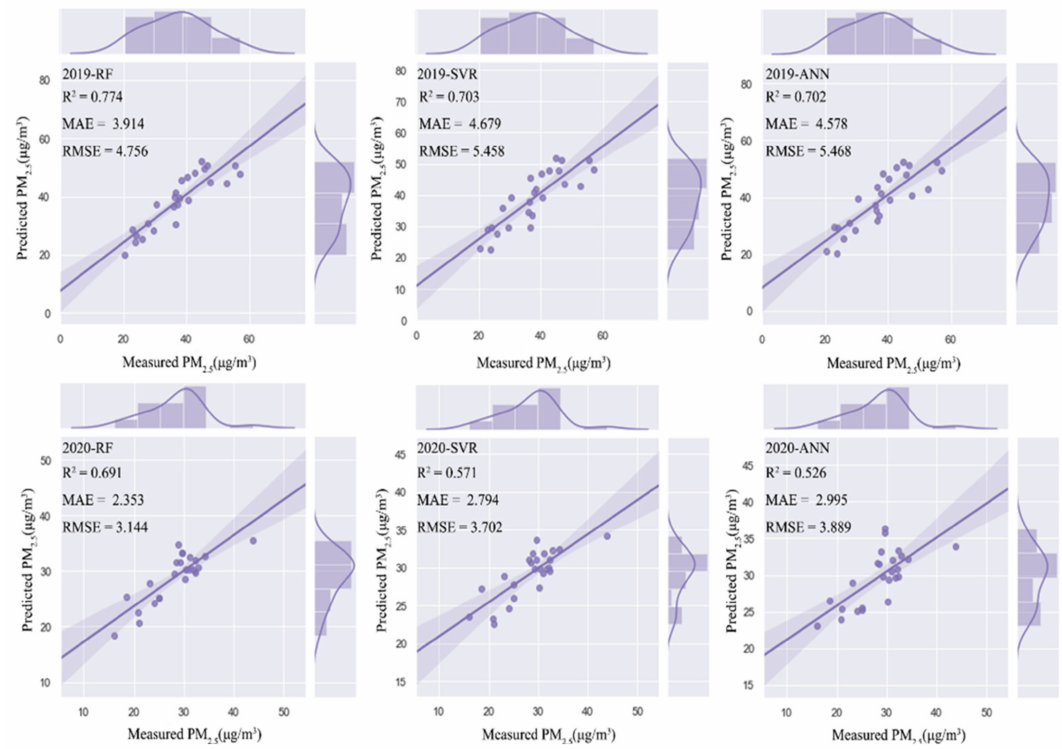
Figure 4. Validation between predicted and measured PM 2.5 by different